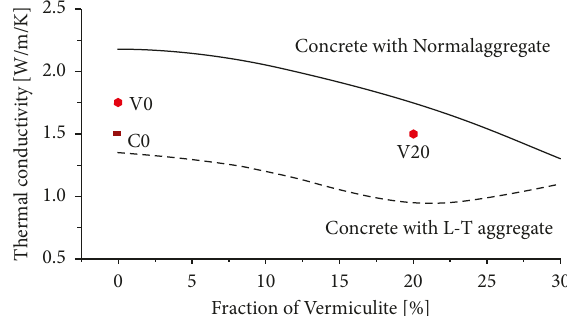
Figure 7: Thermal conductivity of coconut shell and volcanic rock concretes.